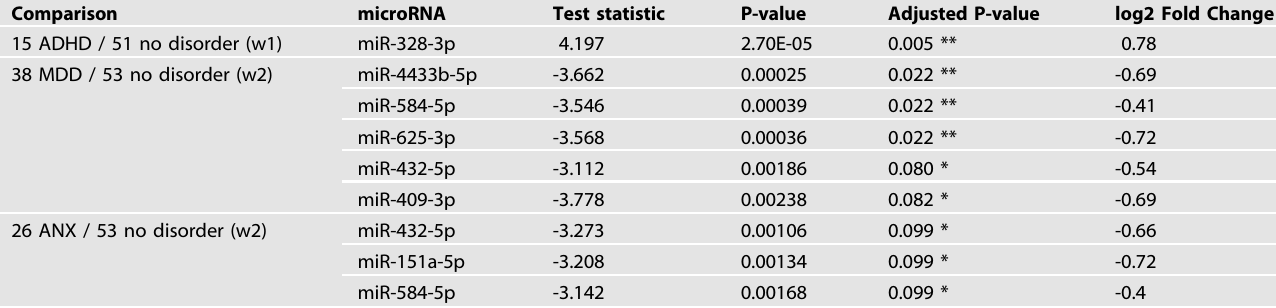
Table 2. Summary statistics of the signi fi cant differentially expressed miRNA.